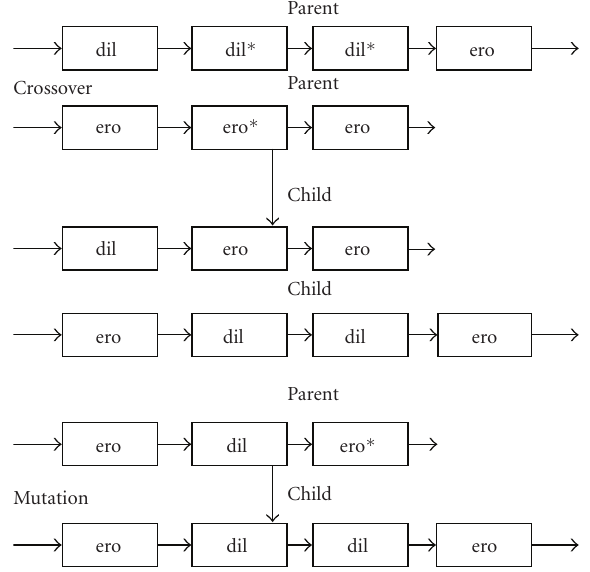
Figure 3: Crossover and mutation operators where ∗ is the selected